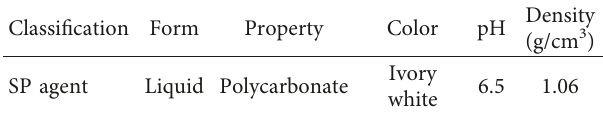
Table 2: Physical properties of admixture.